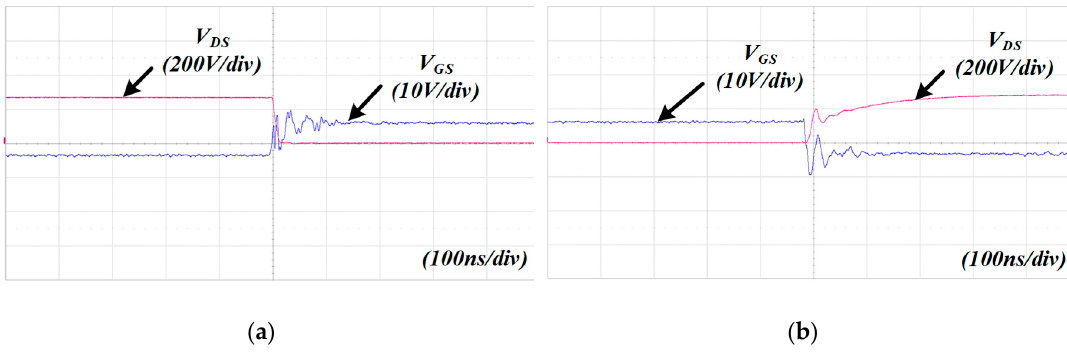
Figure 9. Switching waveform of GaN HEMT in matrix converter; ( a ) at turn ‐ on of GaN HEMT; and ( b ) at turn ‐ off of GaN HEMT.